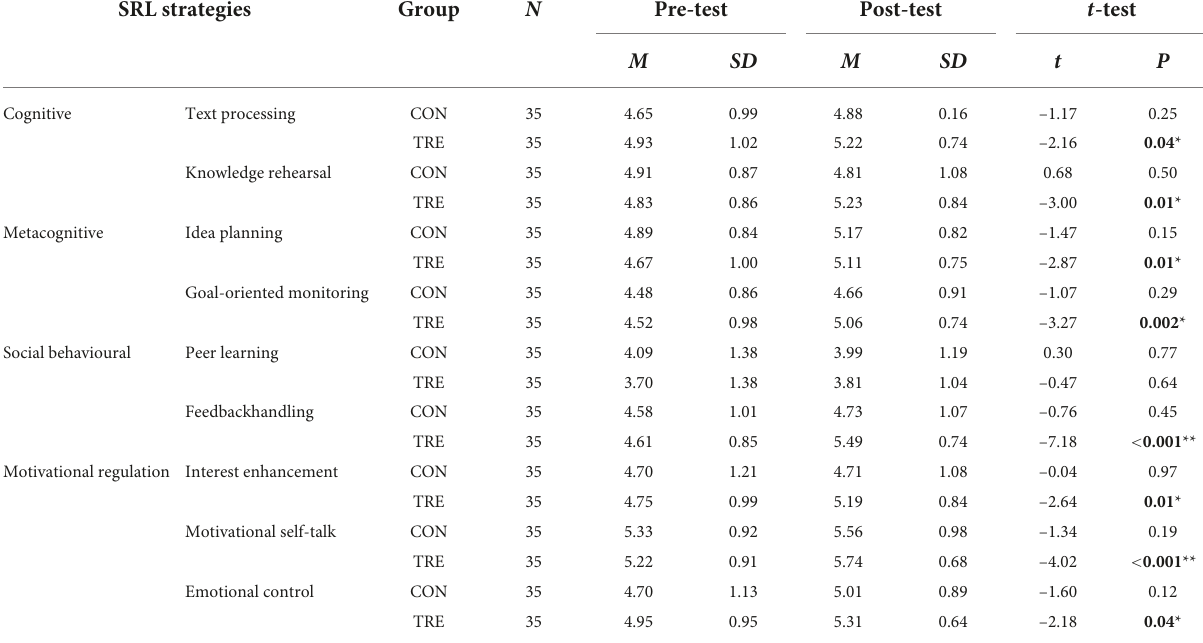
TABLE 9 Descriptive statistics and results of paired-samples t -tests of SRL strategies for the treatment and control groups in the pre- and post-tests. SRL strategies Group N Pre-test Post-test